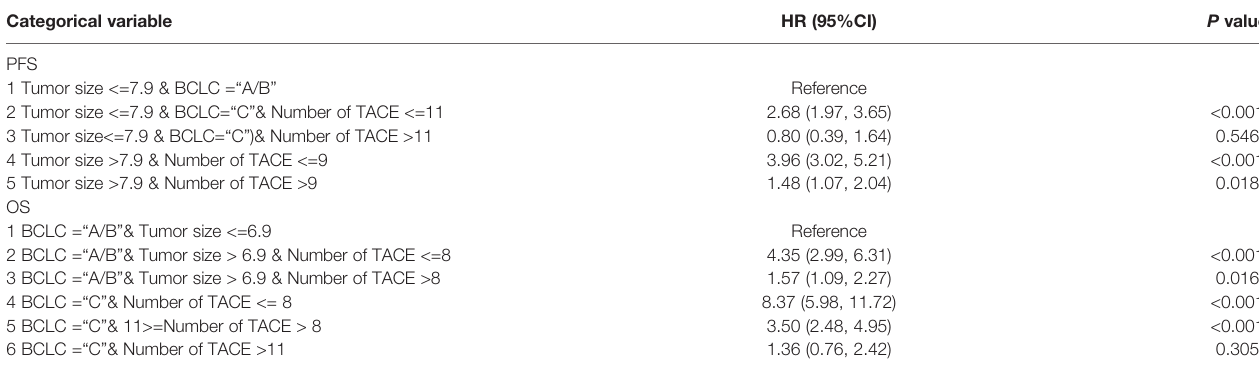
TABLE 4 | The Cox regression analysis of progression-free survival (PFS) or overall survival (OS) according to new stage. Categorical